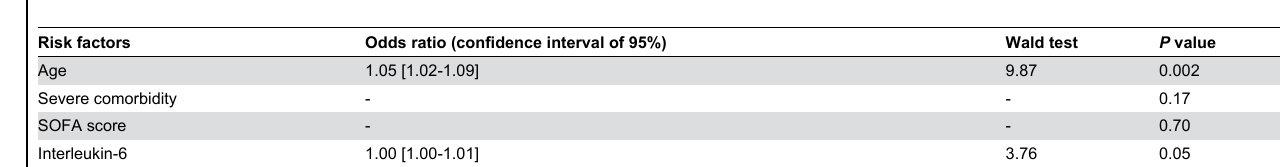
Table 3. Multivariate analysis of hospital mortality among all 60 septic shock